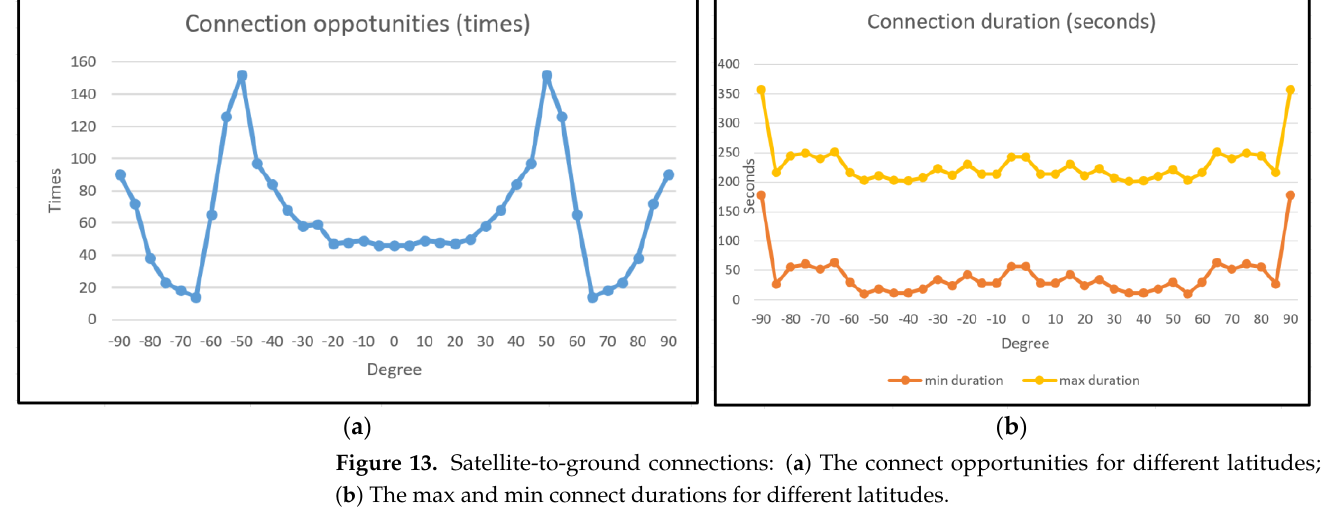
Figure 13. Satellite-to-ground connections: ( a ) The connect opportunities for different latitudes; ( b ) The max and min connect durations for different latitudes. ( b ) The max and min connect durations for different latitudes.